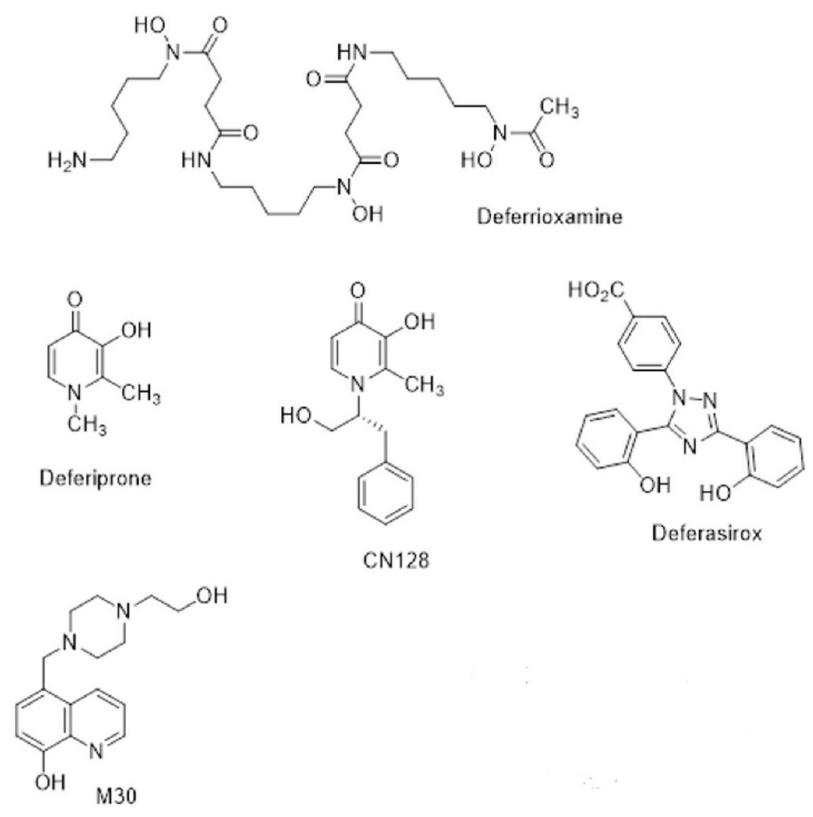
Figure 3. Chemical structures of chelators.